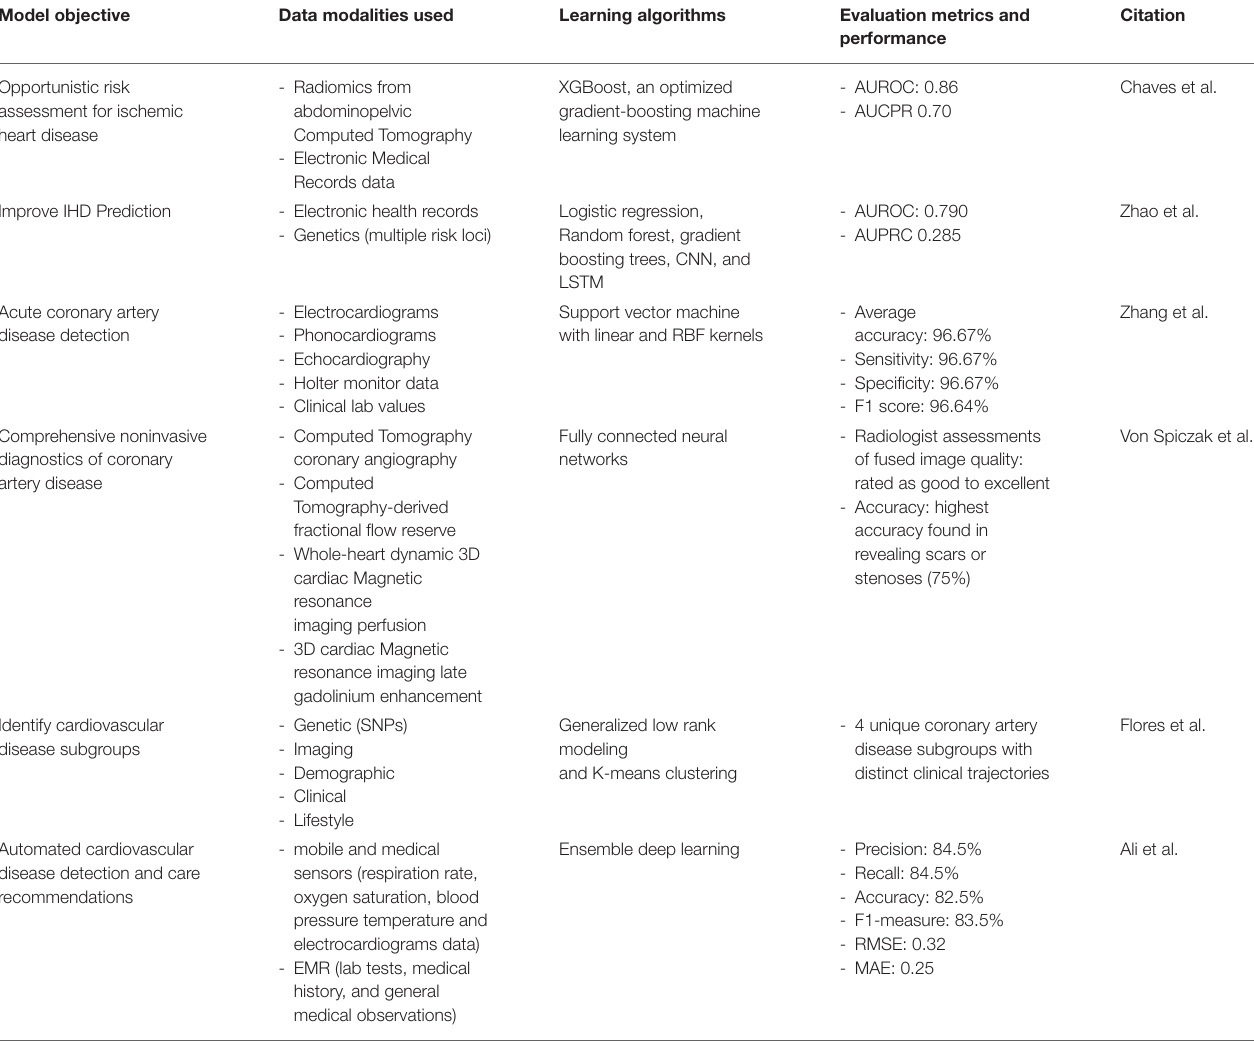
TABLE 1 | Summary of the research in cardiovascular disease care using multimodal